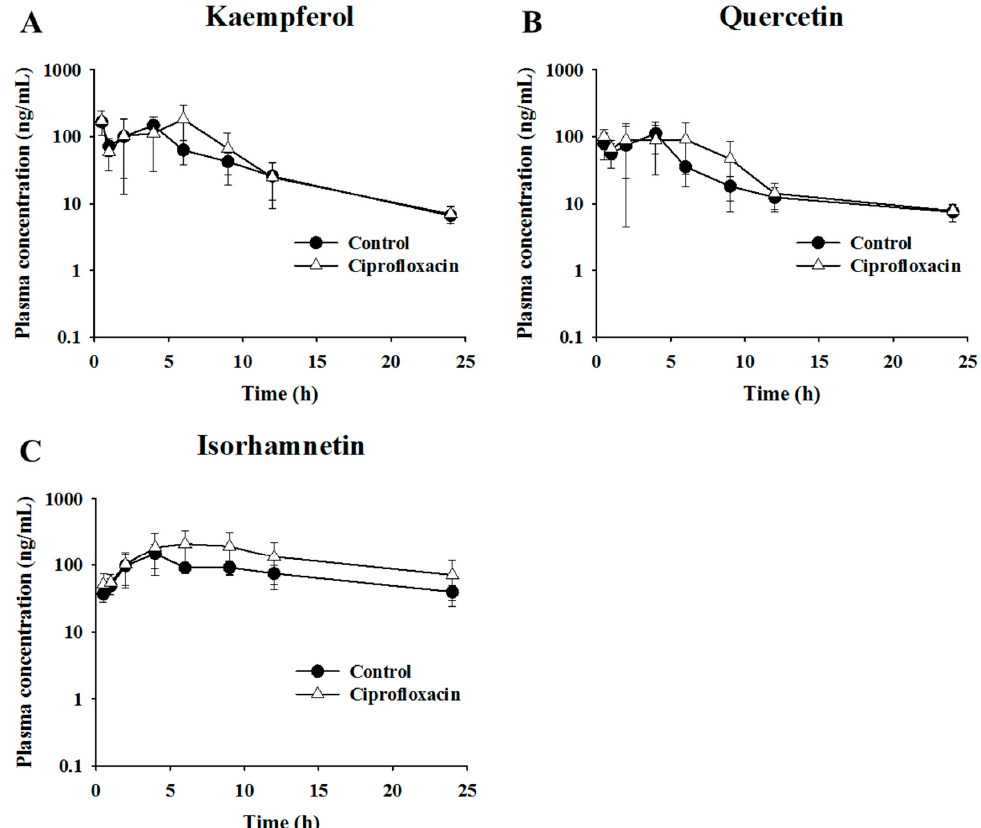
Figure 4. The profiles of mean plasma concentration of flavonols over time after administration of 600 mg/kg ginkgo leaf extract in control and ciprofloxacin-treated mice. Mean plasma concentration–time profiles of ( A ) kaempferol ( B ) quercetin, and ( C ) isorhamnetin. Table 3. Pharmacokinetic parameters of flavonols after oral administration of ginkgo leaf extract in control and ciprofloxacin-treated mice.